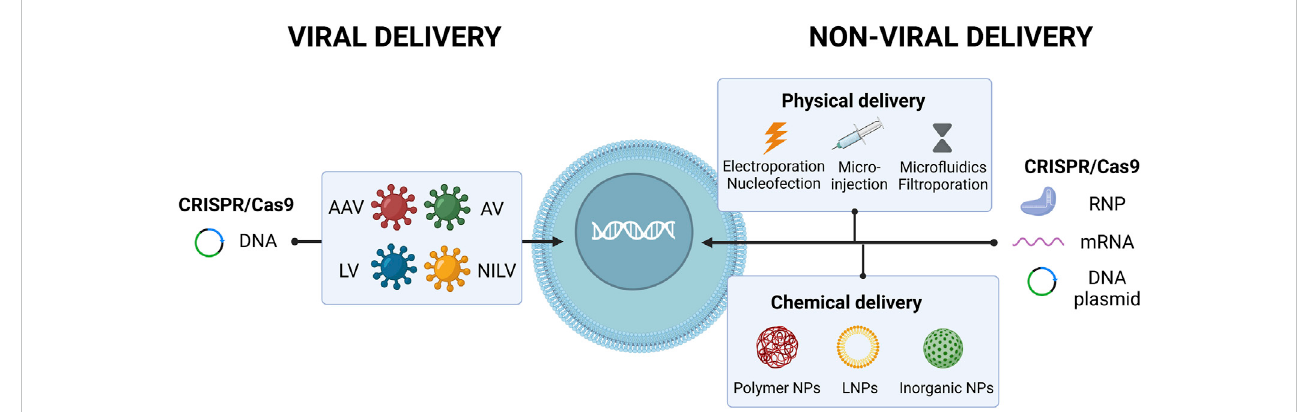
Schematic diagrams of CRISPR-Cas delivery formats and methods. CRISPR-Cas system can be delivered into the cells in DNA, RNA or RNP format. Delivery strategies of CRISPR-Cas9 system are categorized into three groups: physical delivery, chemical delivery and viral